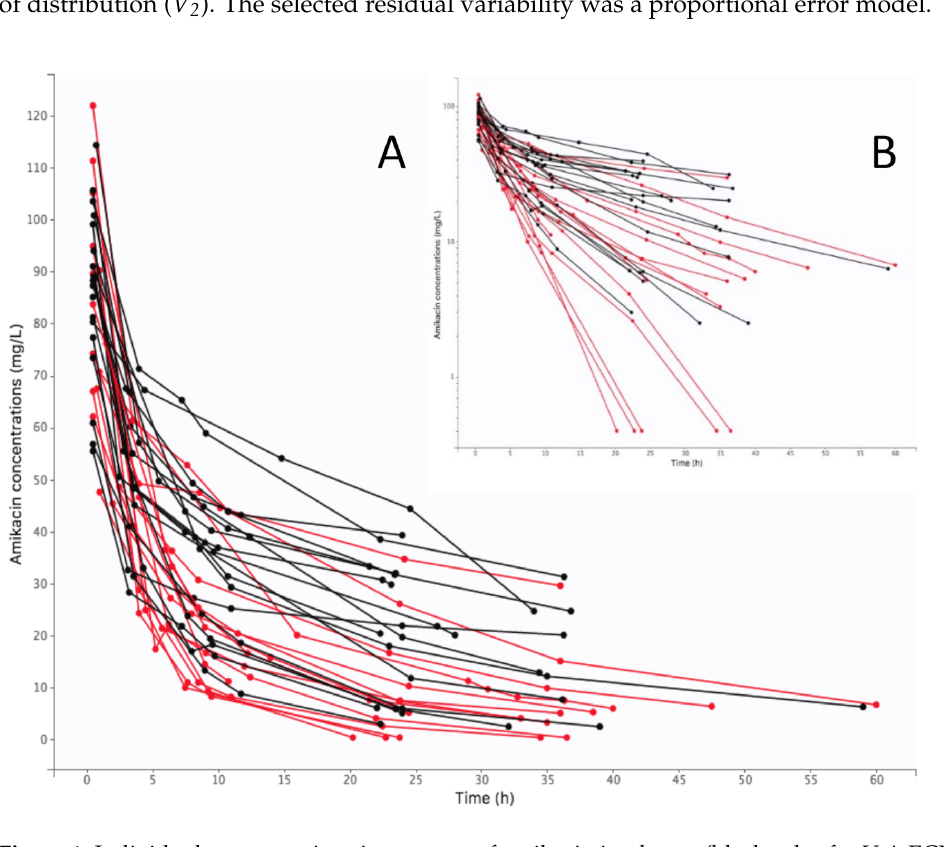
Figure 1. Individual concentration-time curves of amikacin in plasma (black color for V-A ECMO, red color for control): ( A ) arithmetic scale, ( B ) logarithmic